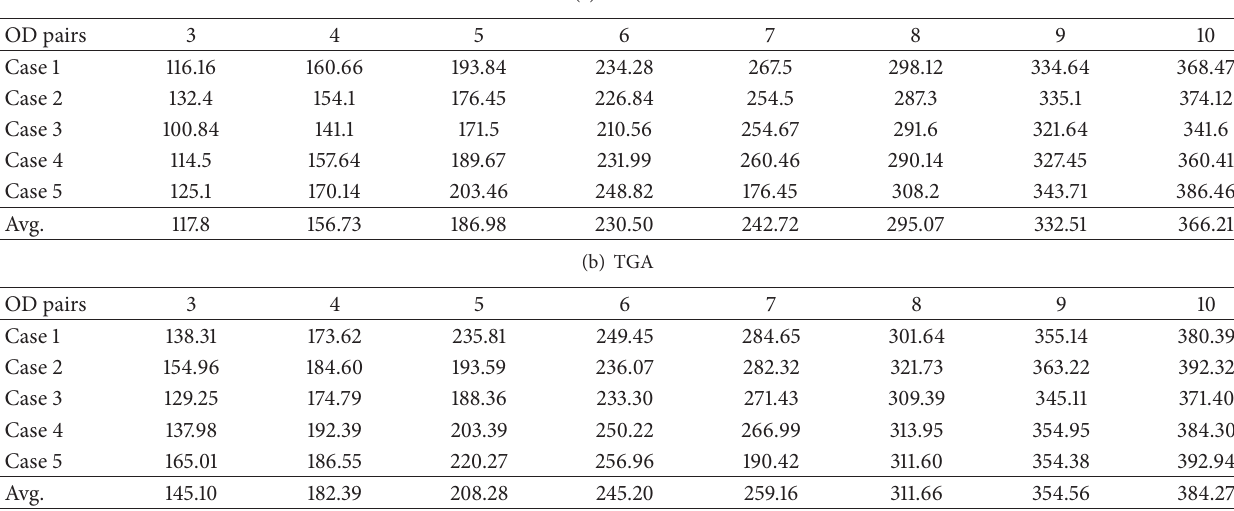
Table 7: The mean experimental results for the low-rate cases (0.25Mbps) obtained by (a) MEGA and (b) TGA.